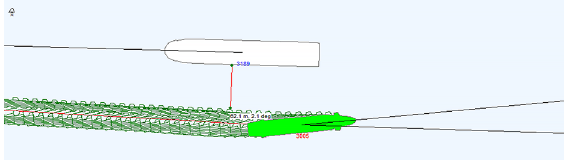
Fig. 9. Scheme for the PANAMAX tanker and a ferry sailing in opposite directions in the port entrance channel and the distance between the ships